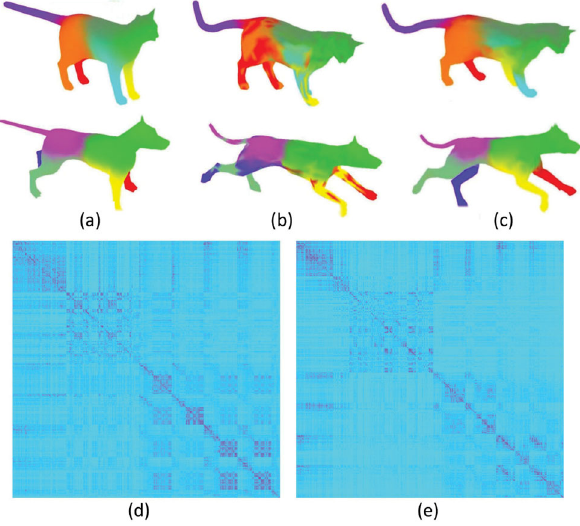
Fig. 8 Pairwise shape correspondence between (a) reference and target shapes (b) without and (c) with the PLS regularization. (d) and (e) are the affinity matrix for the cat and the dog without